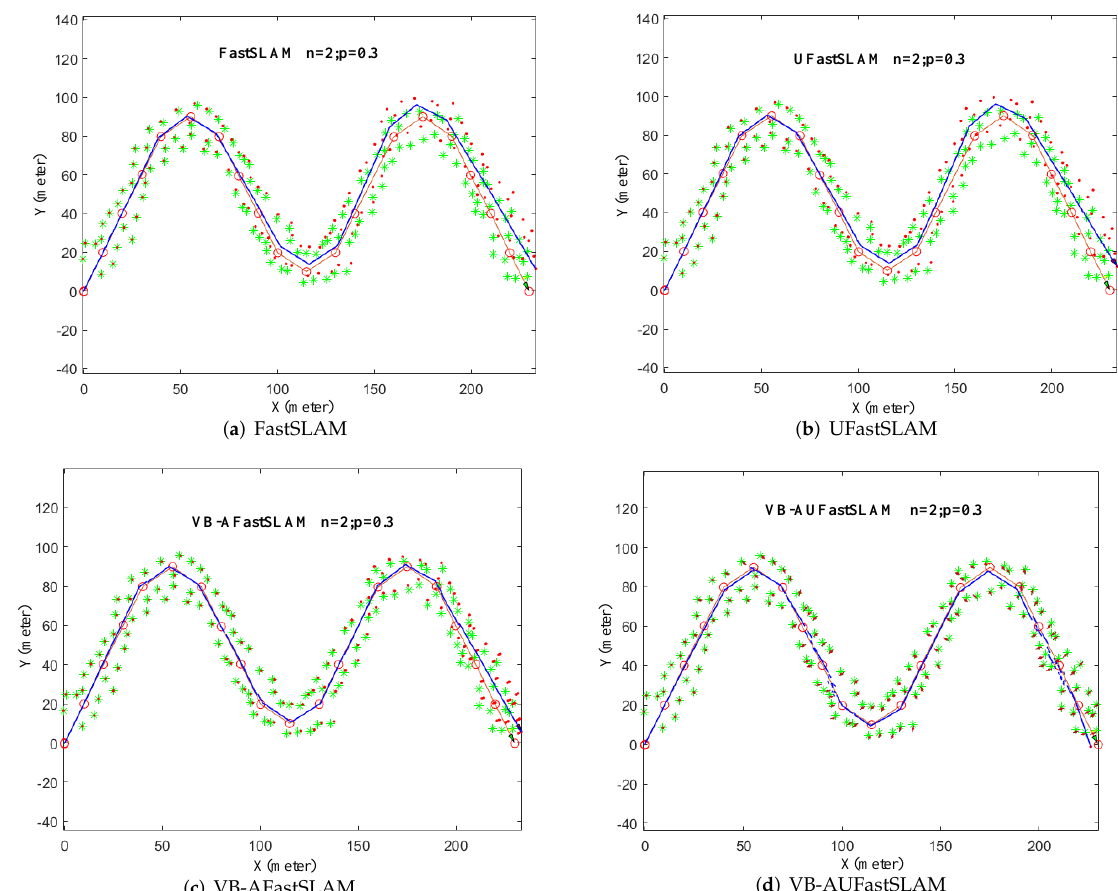
Figure 4. Dynamic observation noise is set to n = 3; p = 0.2.